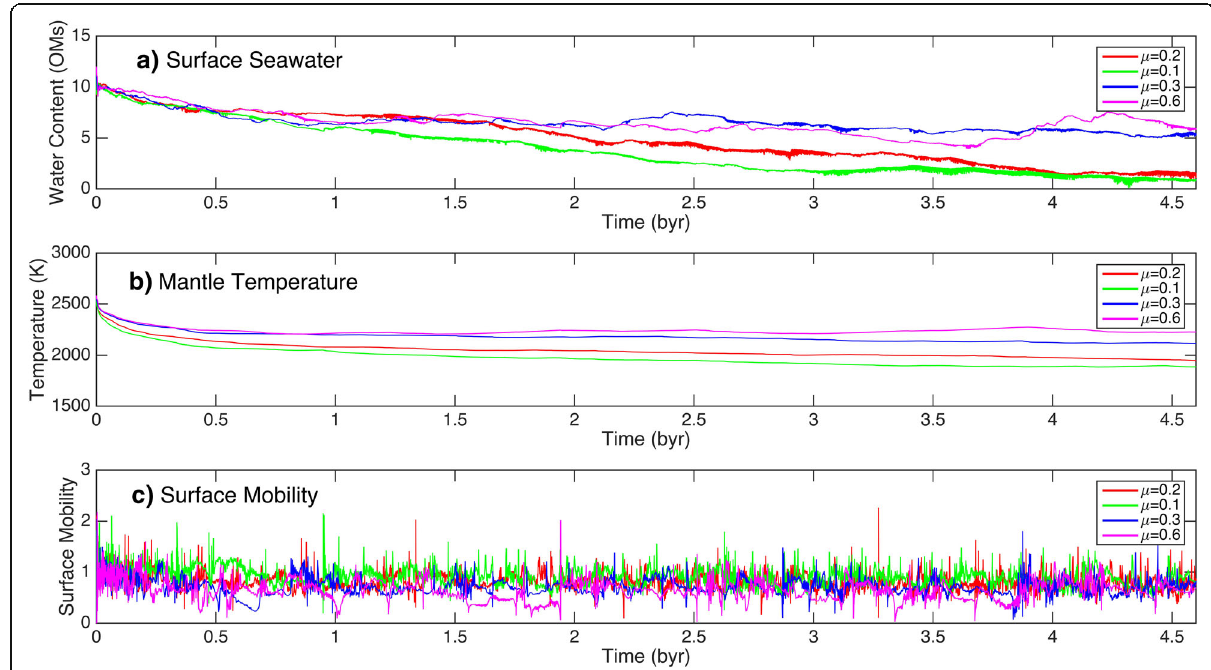
Fig. 8 Temporal variations in the mass of a surface seawater, b mantle temperature, and c surface mobility varying with the friction coefficient of the yield strength of the oceanic lithosphere. The total amount of water is fixed as 12 ocean masses